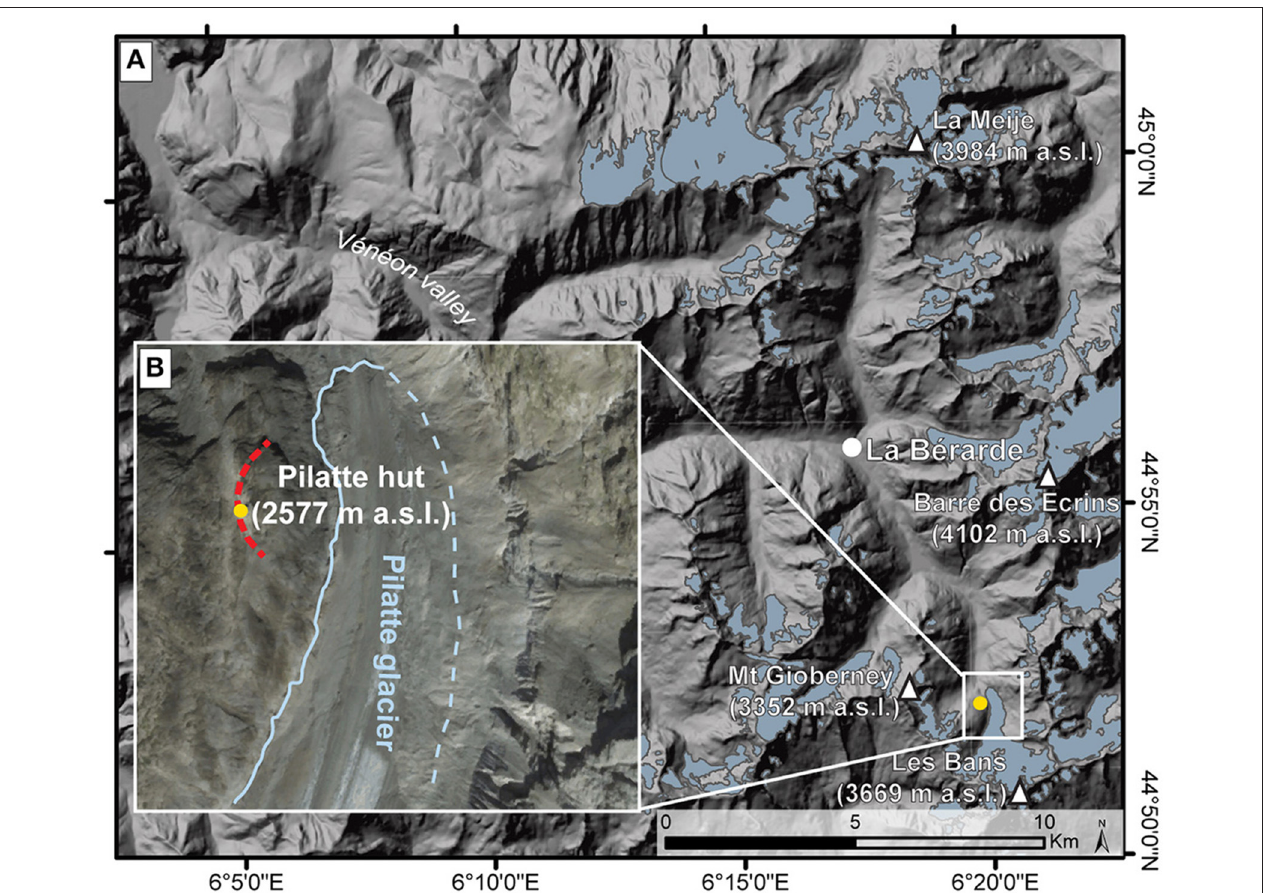
FIGURE 1 | (A) Location of the Pilatte hut in the upper Vénéon valley (IGN 25-m-DEM with glacier extent in blue for the period 2006–2009 from Gardent et al., 2014). (B) The hut above the glacier and the main fracture line (dashed red